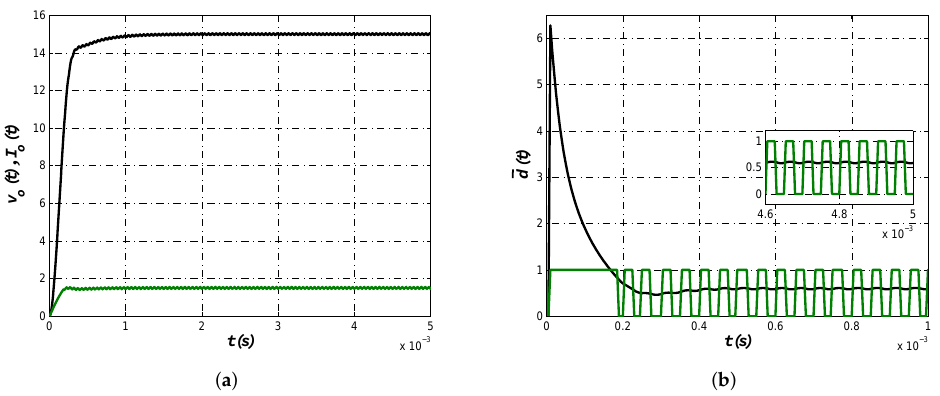
Figure 10. ( a ) Buck output voltage v o ( t ) (black) and inductor current i L ( t ) (green) to determine effective regulation and converter continuous conduction mode operation. ( b ) Control law ¯ d ( t ) = 0.6 and its effect on the PWM signal.